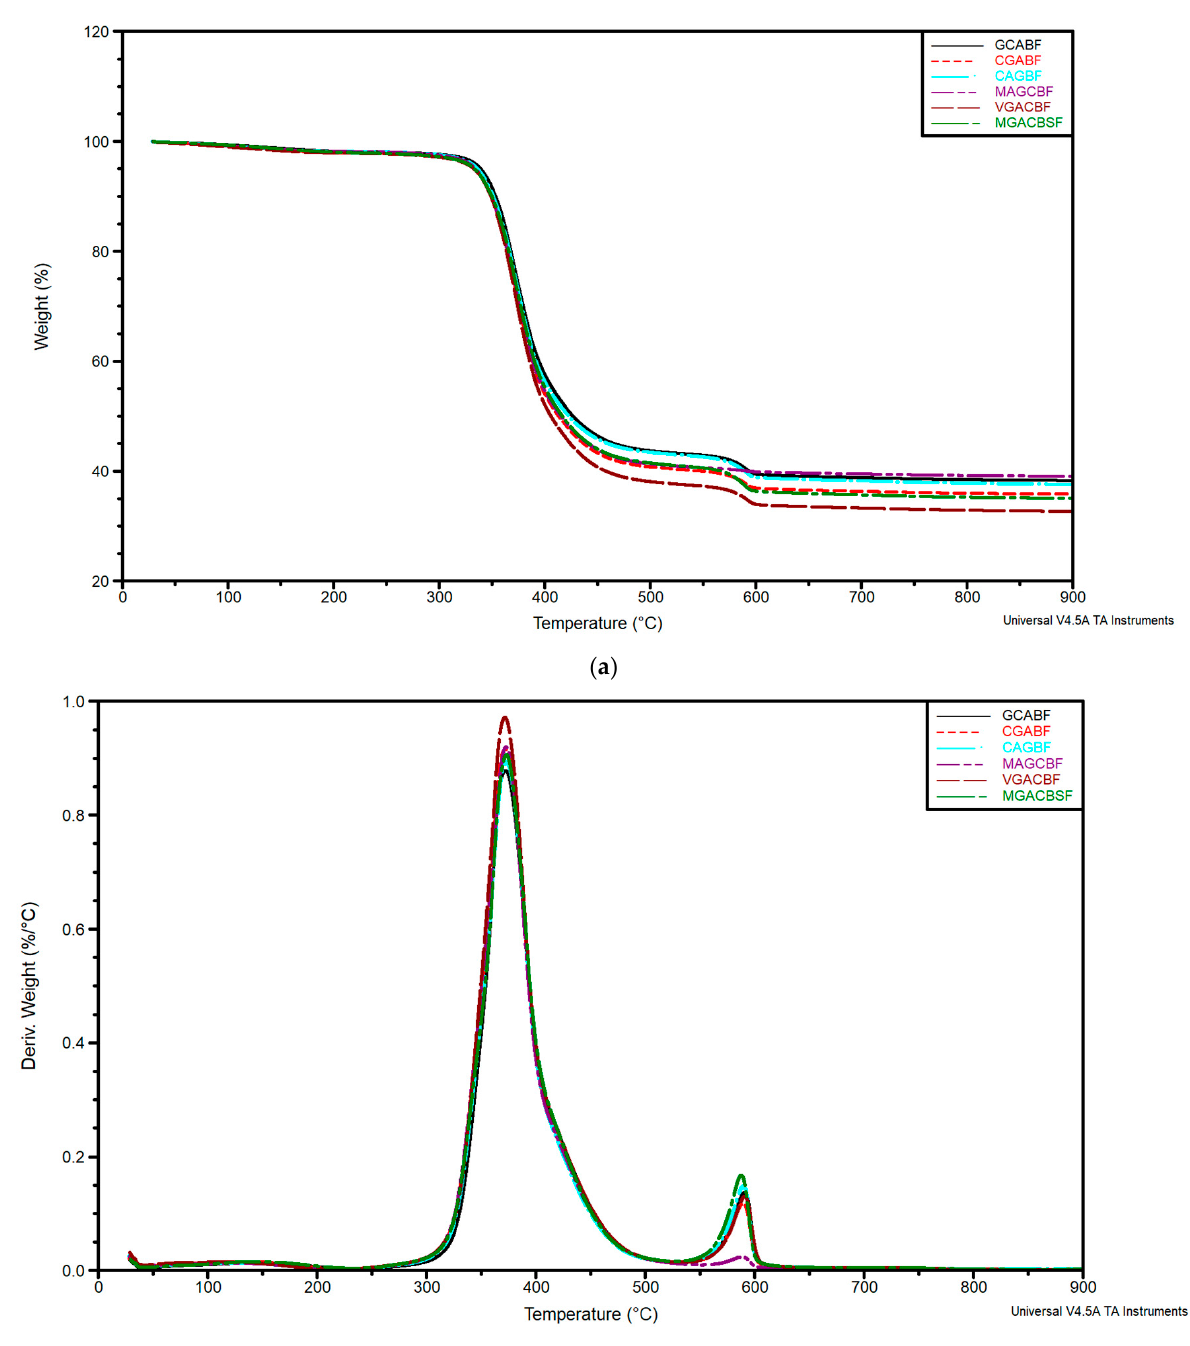
Figure 6. TG ( a ) and DTG ( b ) curves of EP ‐ composites obtained from the thermos gravimetric